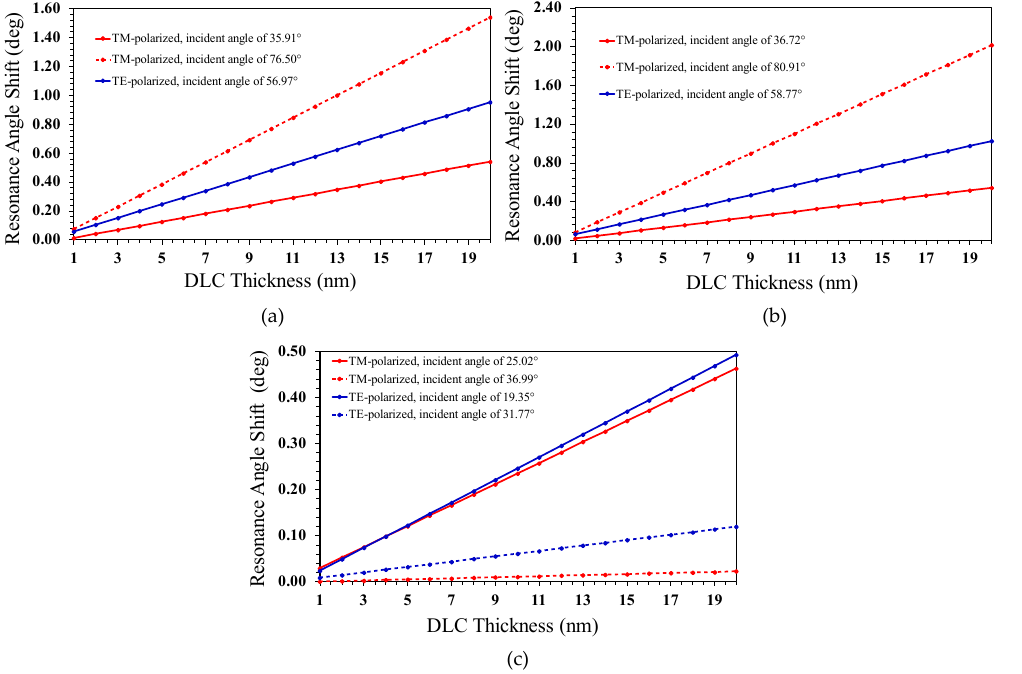
Figure 8. Sensitivity curves as a function of the DLC thickness for the optimized CPWR sensors: ( a ) sapphire prism/TiN/AlN/air, ( b ) magnesium oxide prism/TiN/AlN/air, and ( c ) silicon prism/TiN/AlN/air.